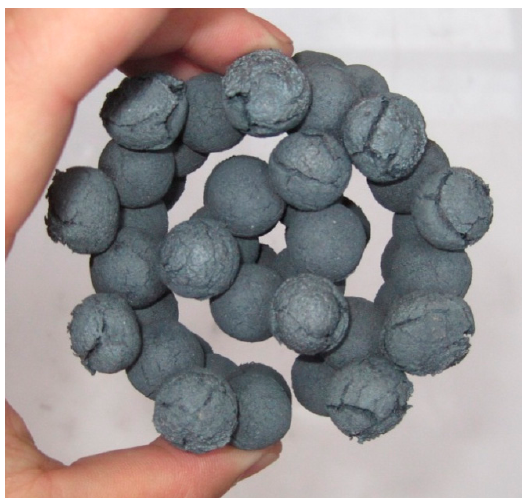
Figure 15. Large space created in the pellets bed due to the shrinkage of DRI.